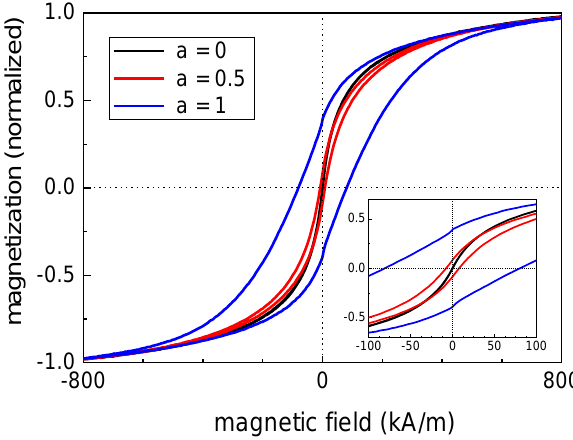
Figure 6. Normalized minor loops of pure magnetite ( a = 0 ) and particles with a Co content of 12.5% ( a = 0.5 ) as well as 25% ( a = 1 ) recorded at room temperature confirm a significant increase in the coercivity for increasing Co content of the particles. The inset depicts a higher magnification of the hysteresis curves at low magnetic field strengths.